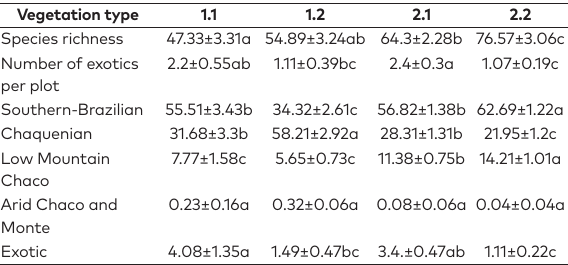
Table 3. Species richness, number of exotics per plot and mean percentage of each chorotype per plot (plus stan- dard error) for each vegetation types classified by ISOPAM analysis. Different letters denote statistically significant differences as identified by ANOVA post-hoc LSD Fisher test. Vegetation type codes: 1.1 Celtis tala / Sida rhombi- folia closed forest; 1.2 Aspidosperma quebracho-blanco / Prosopis kuntzei open forest; 2.1 Jarava pseudoichu / Vach- ellia caven open savanna; 2.2 Acalypha variabilis / Nassella cordobensis